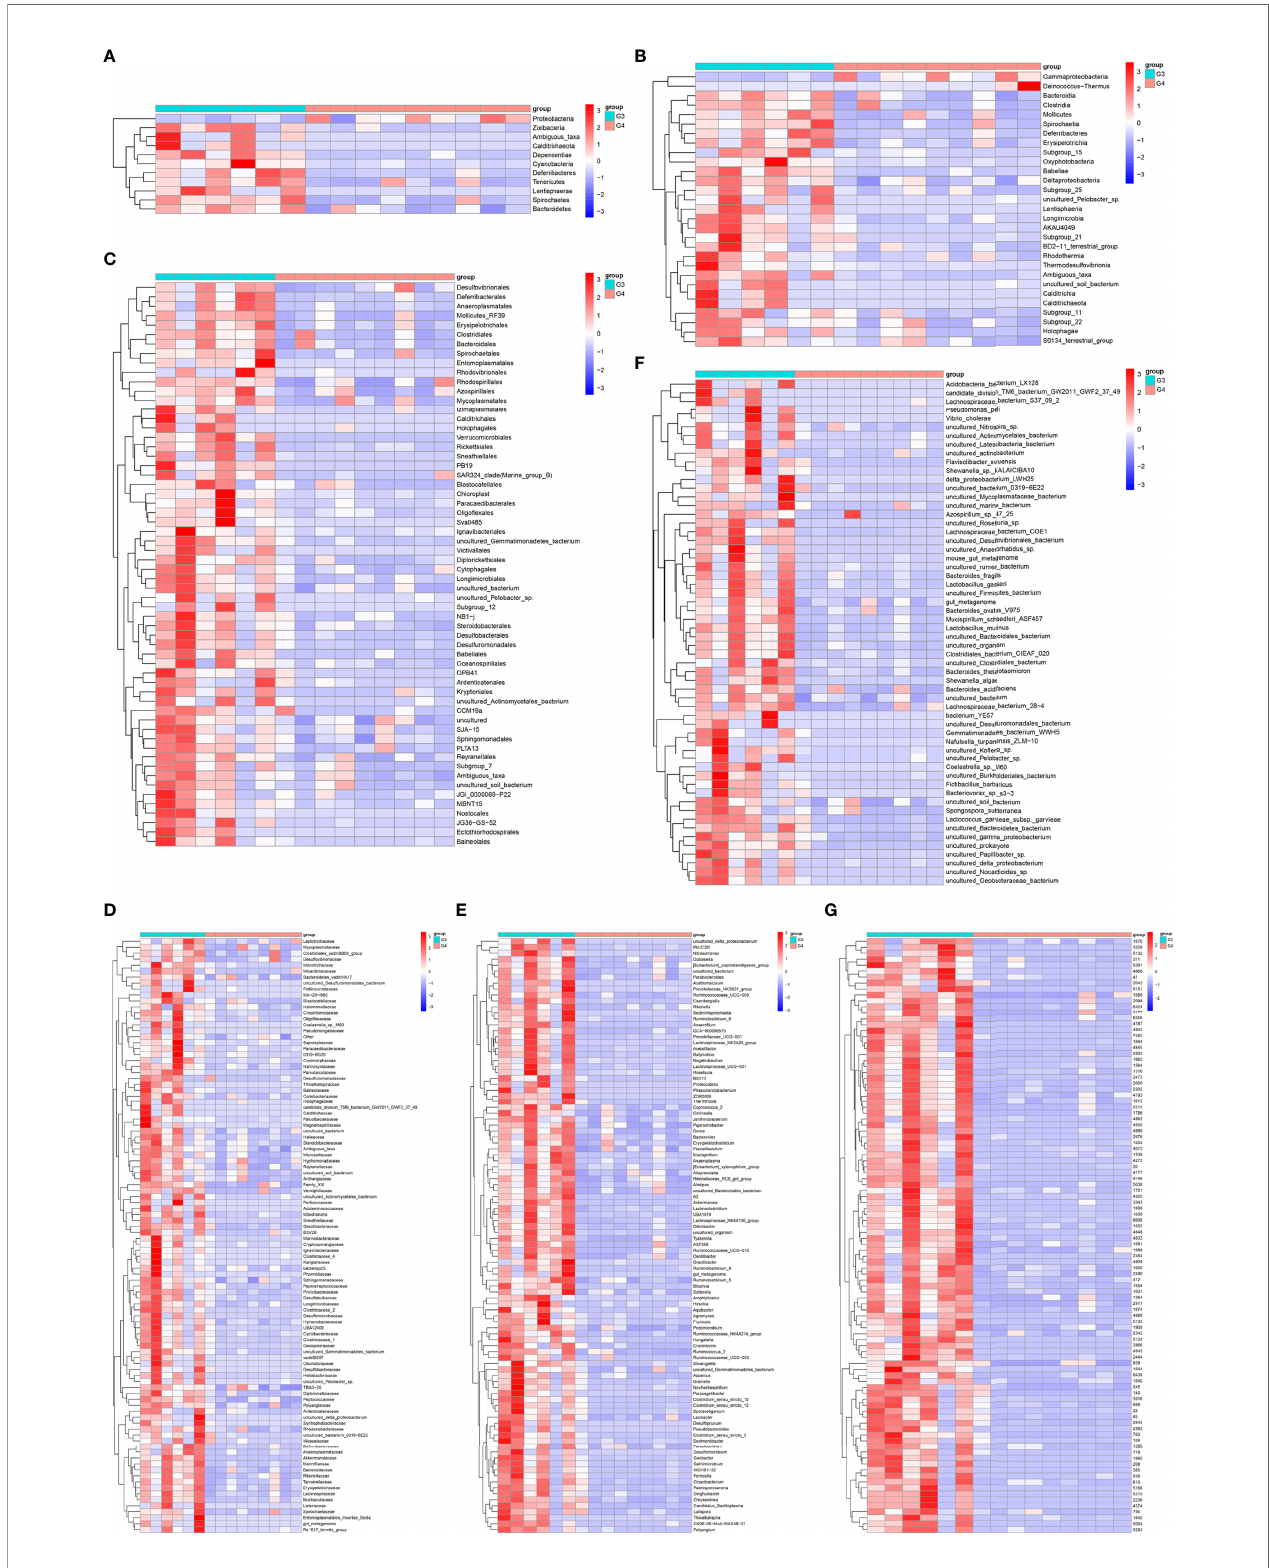
FIGURE 7 | The differential microorganisms at OTU, phylum, class, order, family, genus, and species levels. (A) phylum, (B) class, (C) order, (D) family, (E) genus, (F) species, (G) OTU.